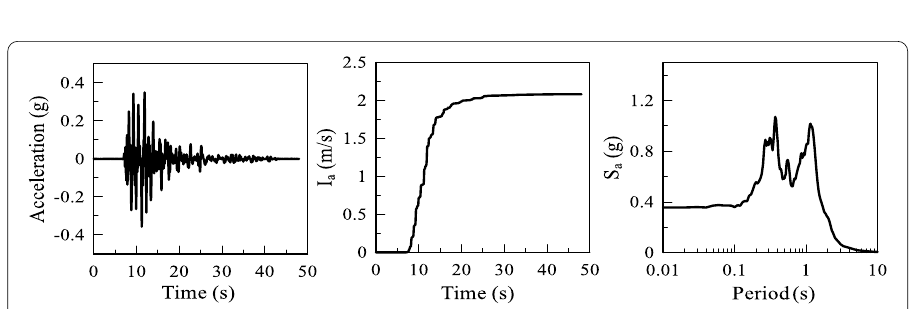
Fig. 2 The acceleration (left) and Arias Intensity time histories (middle) as well as the 5%‑damped response spectrum of the Kobe‑L motion